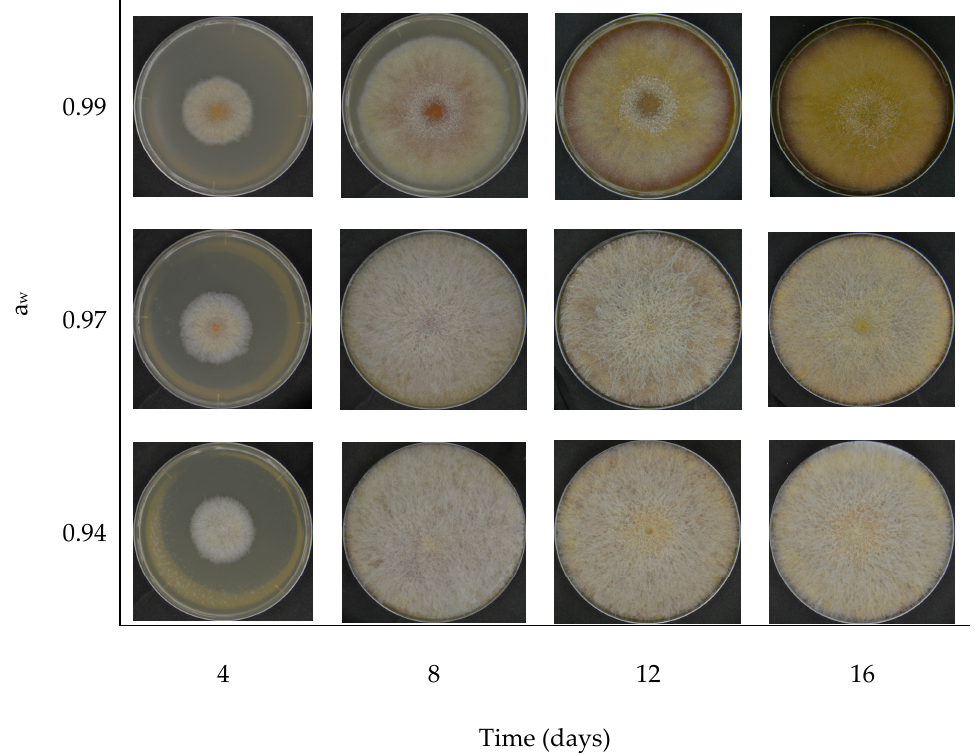
Figure 3. Surface color of F. graminearum grown at different a w for 16 days.